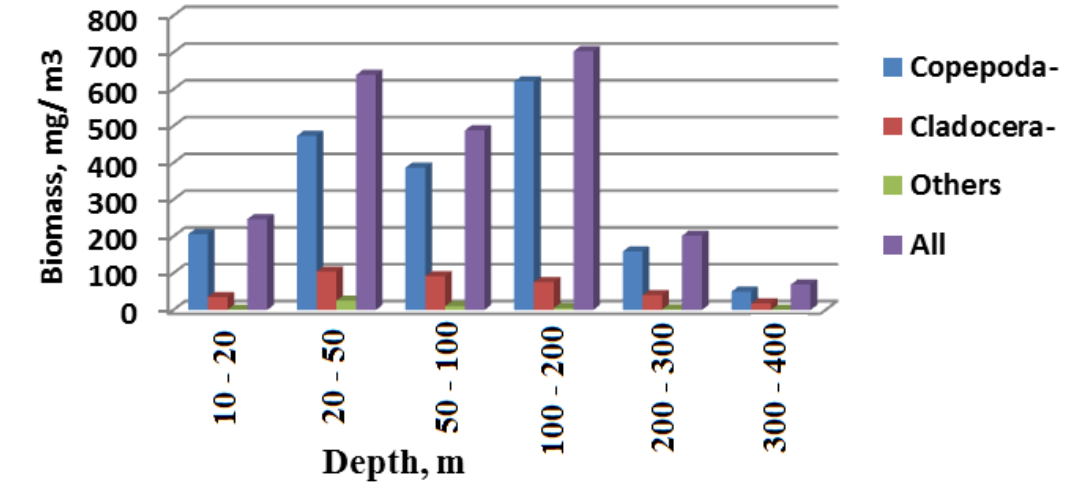
Figure 6. Change in the biomass of taxonomic groups of zooplankton with depth of the eastern section of the Middle Caspian, May 2016. Table 10. Comparative characteristics of the zooplankton structure in the eastern section of the Mid- dle Caspian.